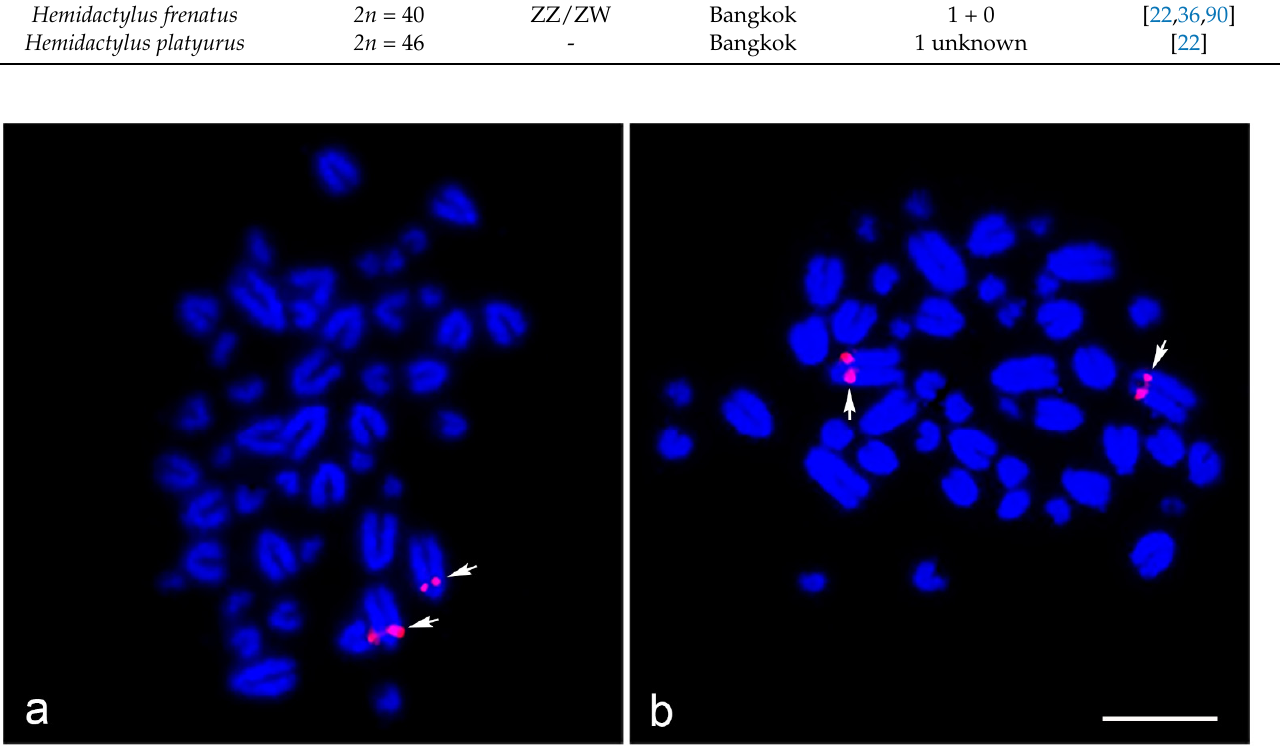
Figure 3. Chromosomal locations of chicken and zebra finch BACs of the flat-tailed house gecko ( Hemidactylus platyurus, HPL) (Schneider, 1797) [73]. GGA23 BAC (Texas Red-labeled TGMCBA-272G9) was located on chromosome 1 (HPL1) ( a ) and GGA27 BAC (Texas Red-labeled CH261-28L10) was located on chromosome 4 (HPL1) ( b ). Arrows indicate hybridization signals. Scale bar represents 10 μ m.